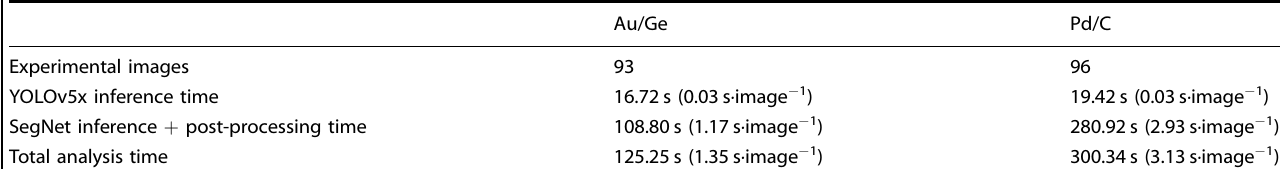
Table 1. Comparison of inference times for individual network modules in nNPipe.